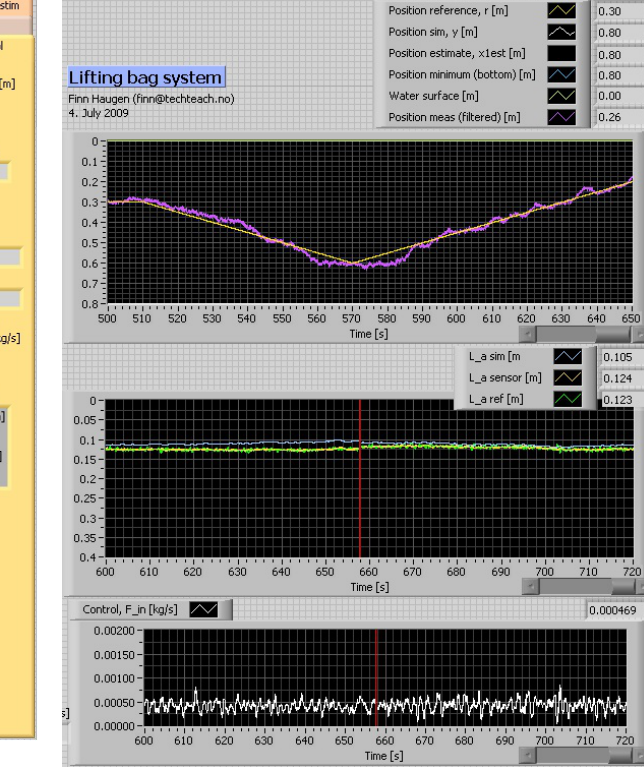
Figure 7: Controller settings of the cascade control sys- tem in LabVIEW. Figure 8: Cascade control with feedforward from esti-